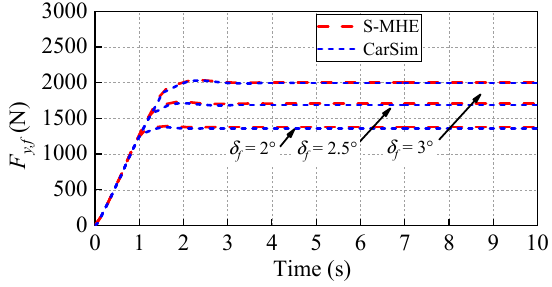
Figure 10. Lateral tire force at front tire estimated by S-MHE.